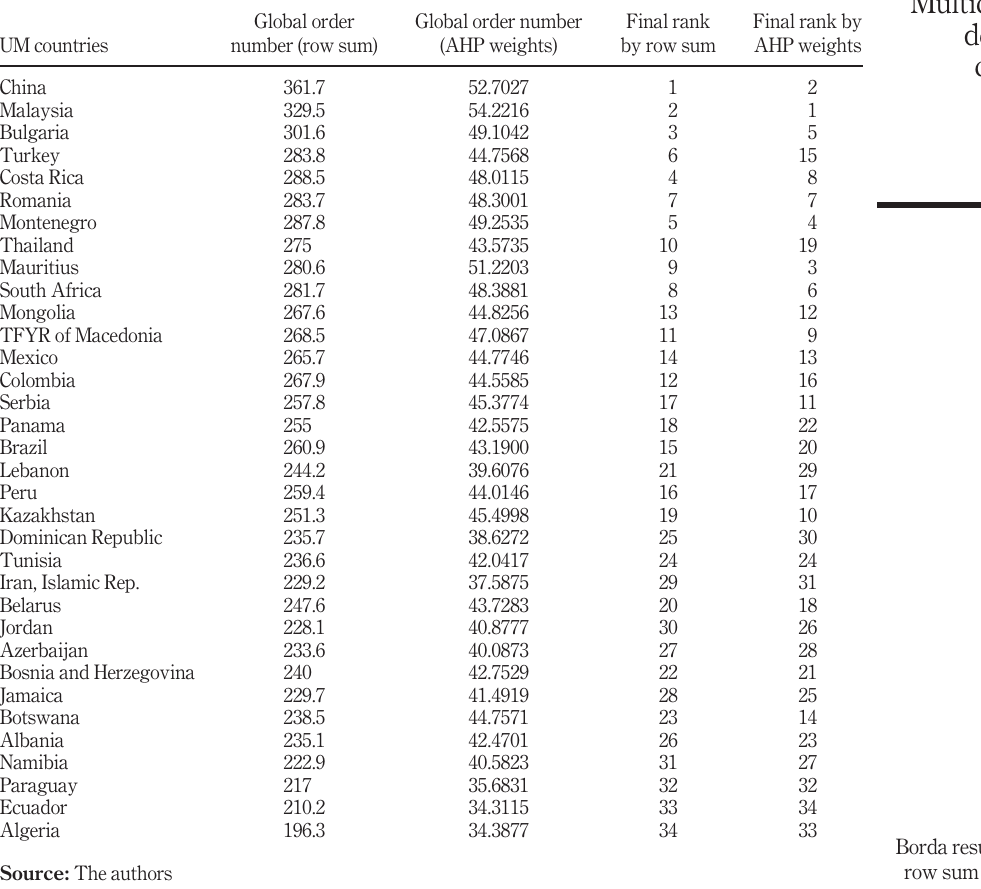
Table 6. Borda results